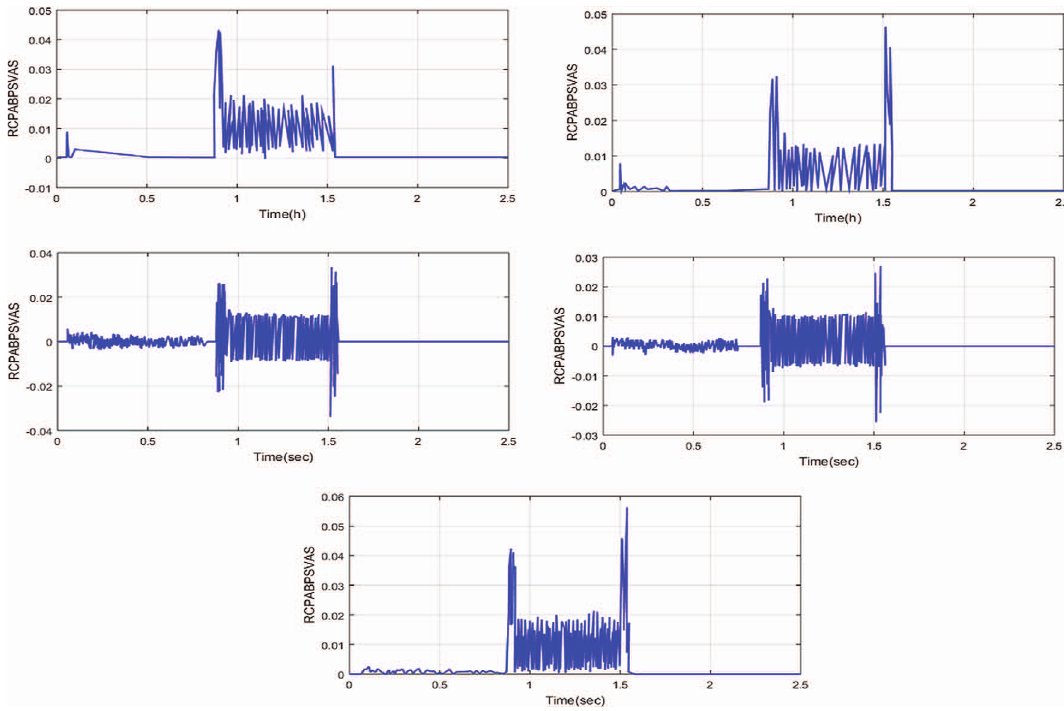
Fig. 10. System performance under balanced loading